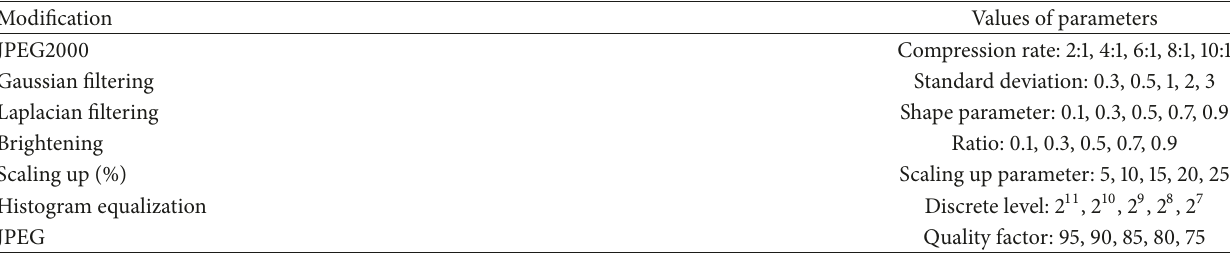
Table 1: Image modification types and their parameterizations.